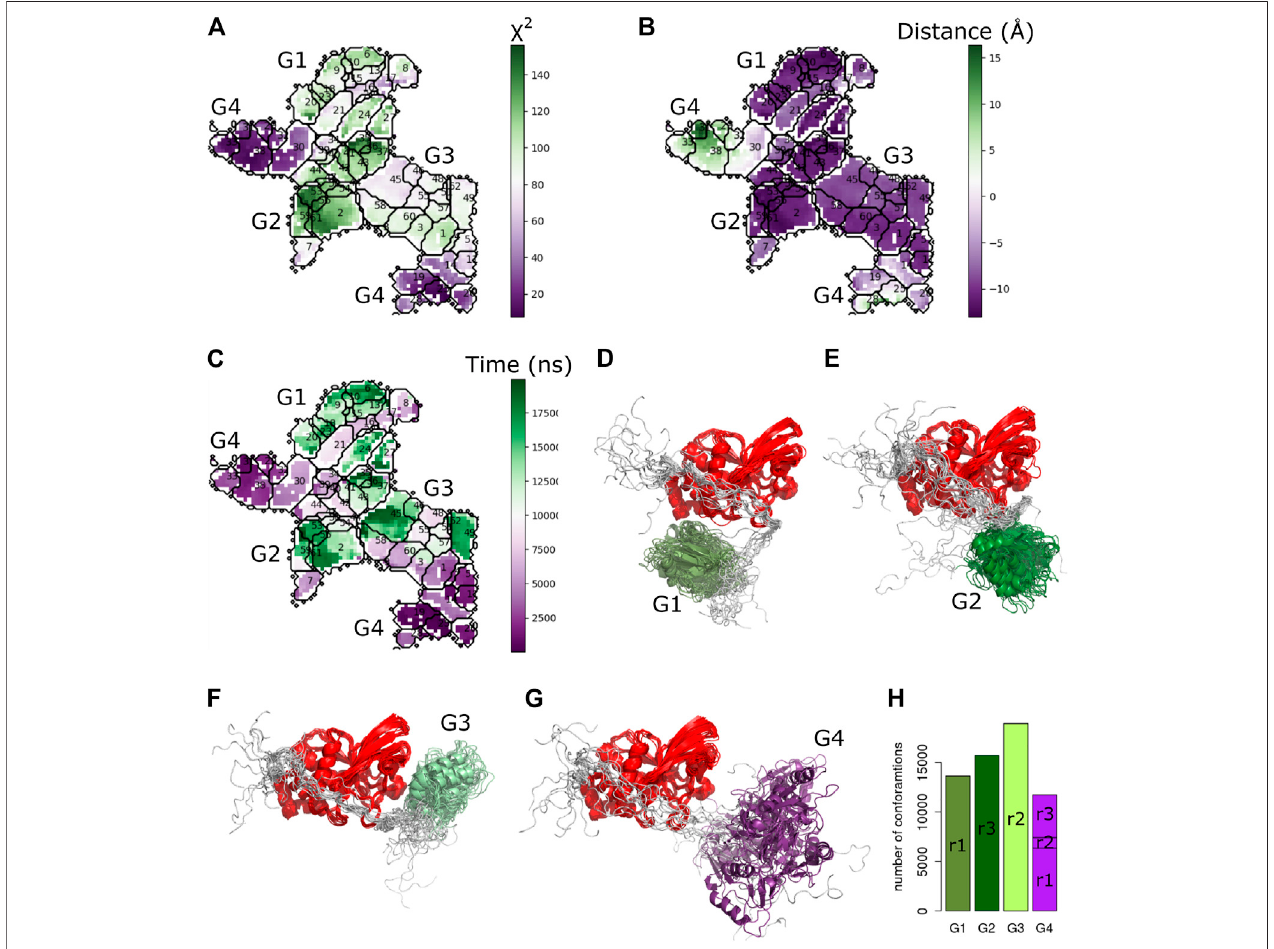
FIGURE 9 | Cluster analysis of PTPN4 from the MD simulations. The self-organizing map of the PTPN4 conformations colored by (A) χ 2 , (B) changes of distances between the center of mass of the PDZ and PTP domains, and (C) simulations time (ns) of the replicates. The clusters are numbered on the maps from 1 to 60, and divided into four groups (G1-G4). One representative conformation is shown for the clusters that are forming the four groups G1, G2, G3 and G4 in (D – G) , respectively. The PTPiscoloredinred and the fouridenti fi edgroups ofPDZclustersindifference shades ofgreenand purple, re fl ecting their average χ 2 values. (H) Thenumber of conformations from different replicates (r1, r2, and r3) are reported for each